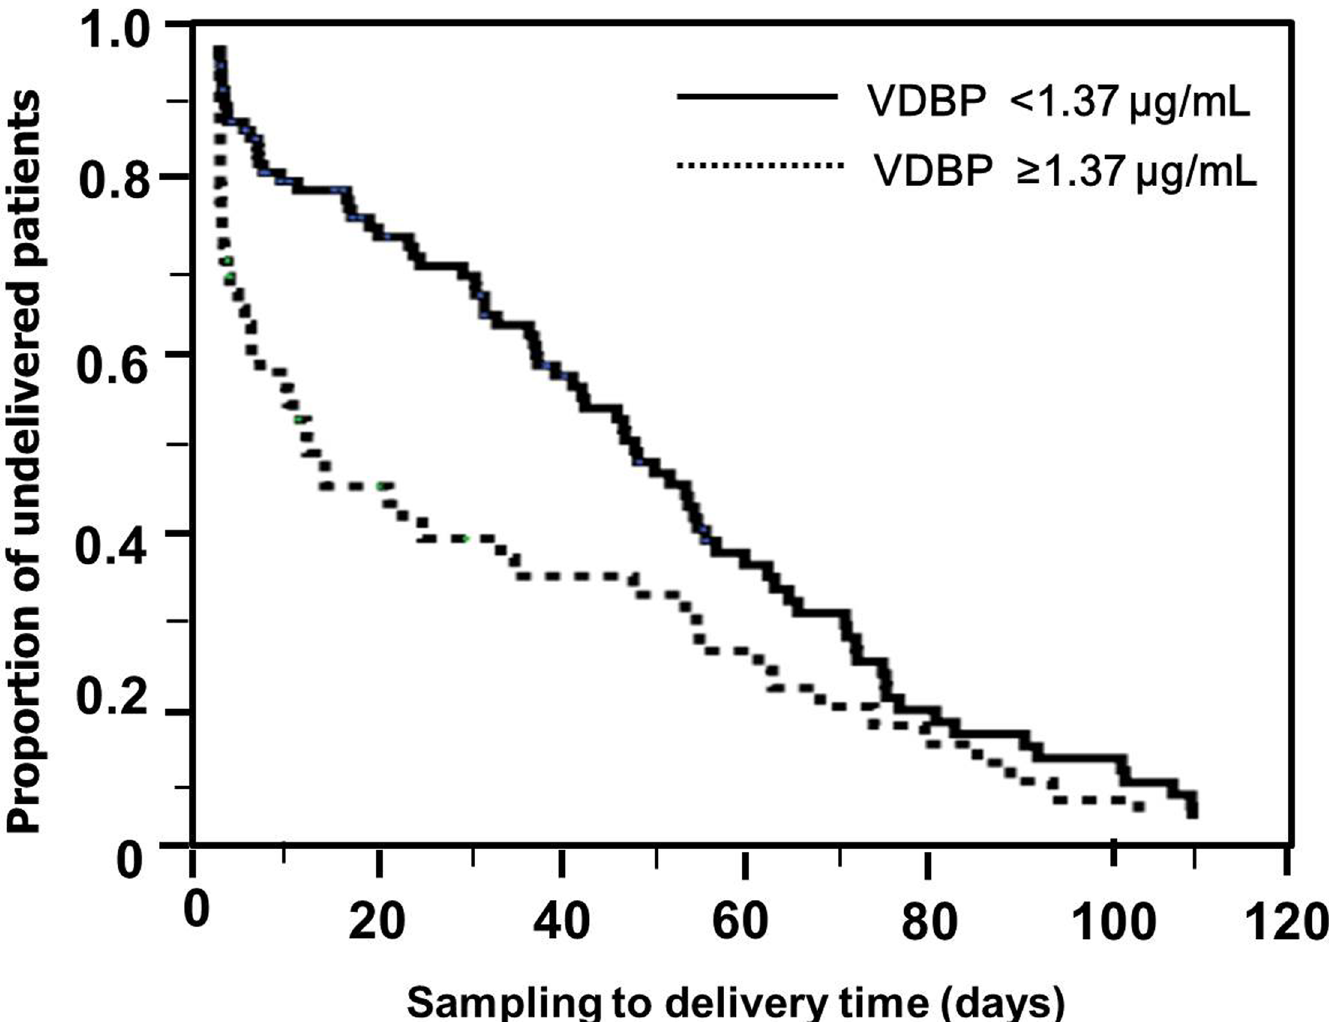
Fig 2. Kaplan-Meier survival estimates of the sampling-to-delivery interval according to the levels of vitamin D-binding protein (VDBP) in the cervicovaginal fluid of women with preterm labor and intact membranes (using 1.37 μ g/mL as a cut-off) (median, 9.91 days [95% confidence interval (CI), 5.17–14.65] vs. 45.87 days [95% CI, 36.84–54.90]; P = 0.003).